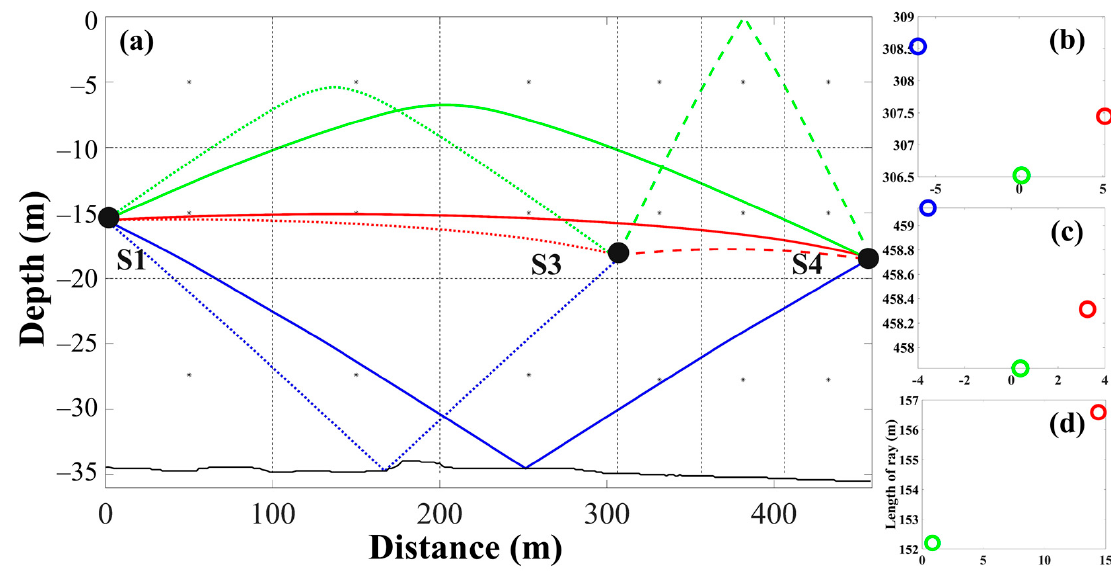
Figure 6. Ray simulation and launch angle: ( a ) shows the sound ray structure of three station pairs. ( b – d ) are the relationships between S1 to S3, S1 to S4, and S3 to S4, respectively. The abscissa axis is the launch angle of signals; the ordinate axis is the corresponding ray length. The colors of rays and circles correspond to those in the multi-peak identification.